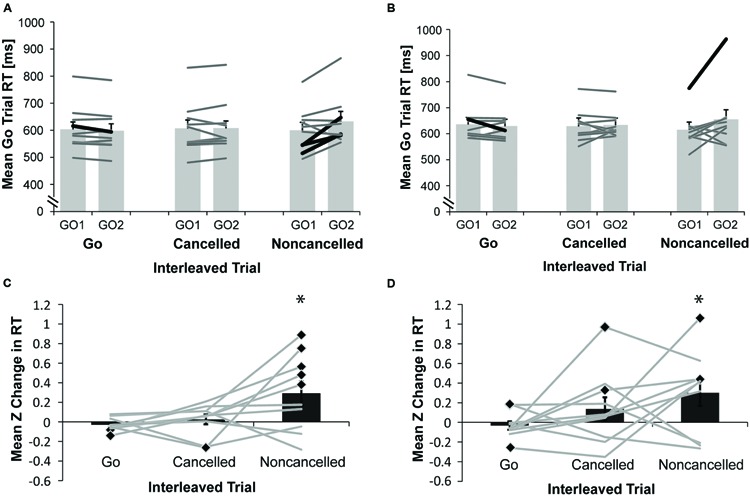
Adaptive RT adjustments. (A,B) Light gray bars compare mean ± SEM go trial RT for sets of three consecutive trials where go trials immediately preceded (GO1) and followed (GO2) either a correct go, a canceled stop or a non-canceled stop interleaved trial, for rats (N = 10) performing the countermanding task at (A) 7 months of age or (B) 12 months of age. Heavy black lines show individual animal mean RTs where GO1 and GO2 were significantly different (paired t-test, p < 0.05) whereas dark gray lines show individual animal mean RTs where GO1 and GO2 were not significantly different. (C,D) Dark gray bars show mean (± SEM) Z change in go trial RT for trials following, compared to trials preceding, an interleaved correct go, canceled stop or non-canceled stop trial for rats (N = 10) at (C) 7 months of age; or (D) 12 months of age, where Z = [GO2RT(trial) – GO1RT(mean)]/GO1RT(standard deviation). Light gray lines represent Z scores for each individual animal at each interleaved trial type (∗significant difference of mean Z score from zero with one-sample t-test, p < = 0.05; black diamonds indicate significant difference of an individual animals Z score from zero with a one-sample t-test, p < 0.05).